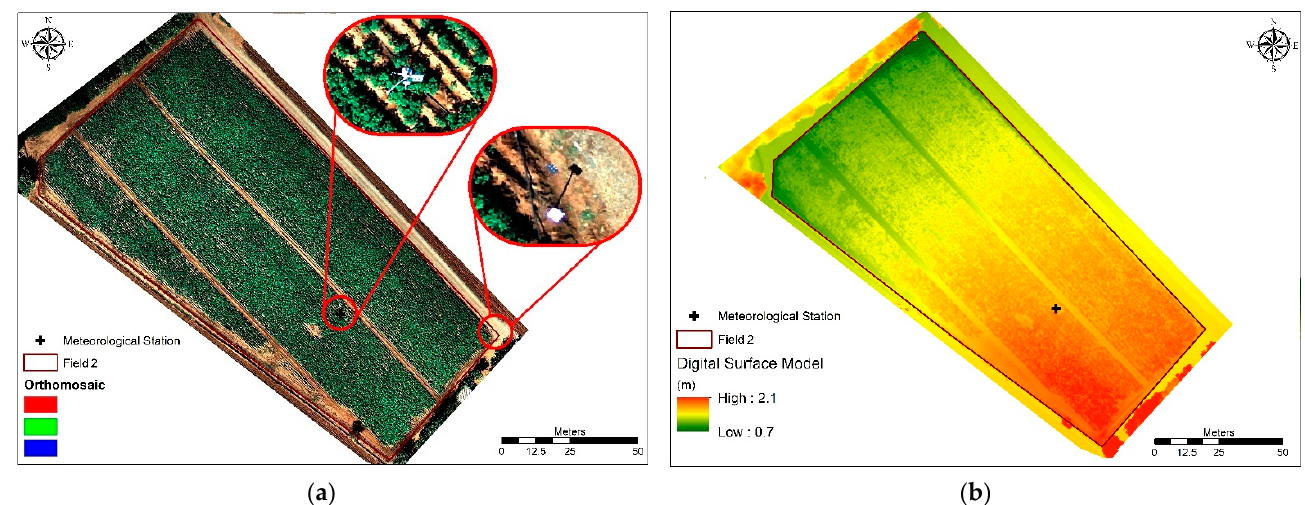
Figure 13. ( a ) The very high-resolution true color orthomosaic and ( b ) the very high-resolution digital surface model of field 2.